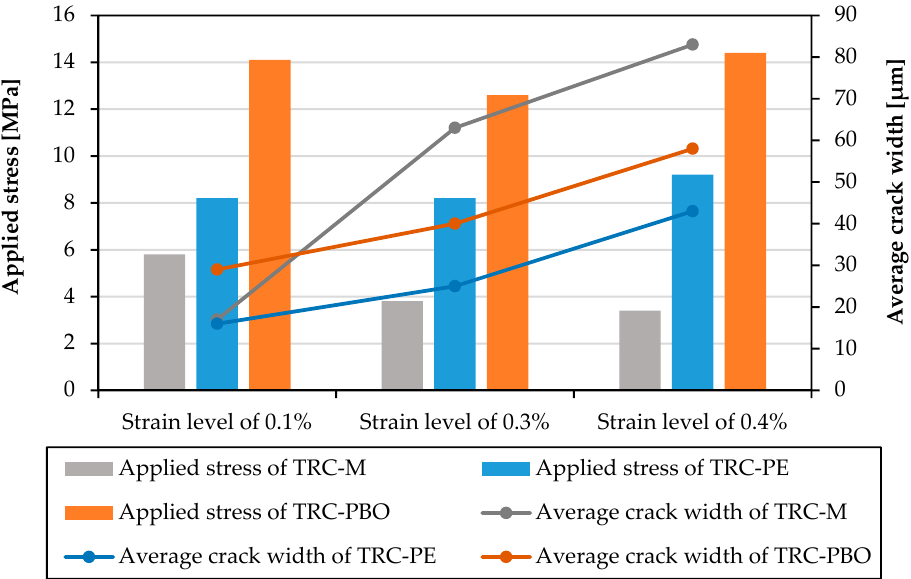
Figure 12. Average crack width and applied stress for representative specimens under impact tensile loading.